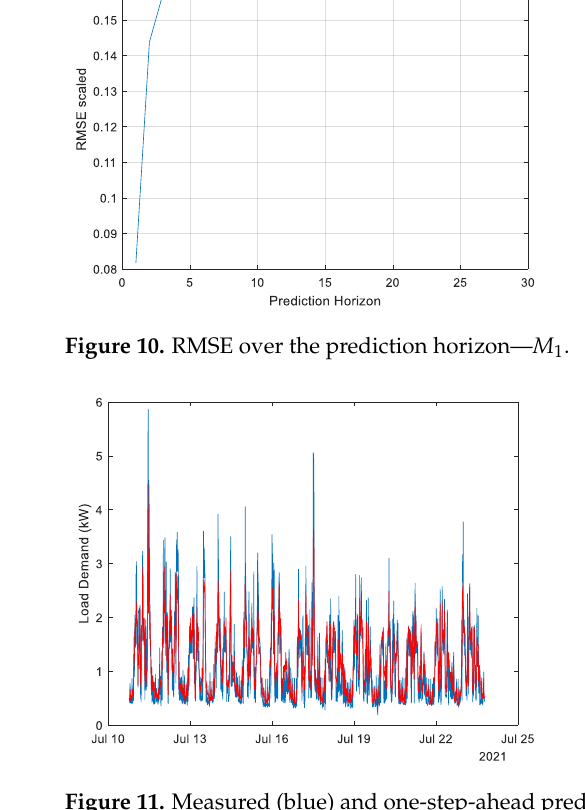
Figure 11. Measured (blue) and one-step-ahead predicted (red) load demand.